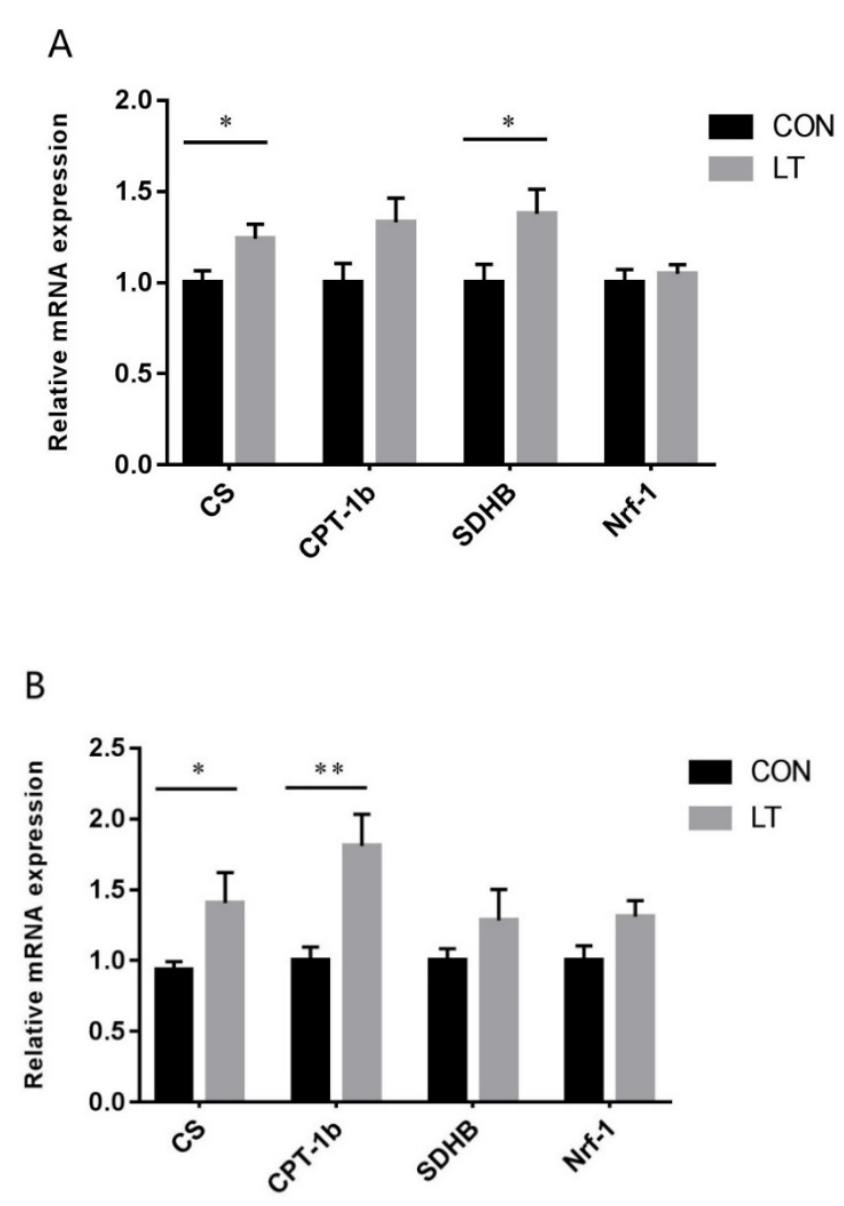
Figure 2. Effects of low-temperature on the mRNA expression level of mitochondrial function-related genes in ( A ) LM and ( B ) PM of weaned piglets. Results were the mean and standard errors. CS, citrate synthase; CPT-1b, carnitine palmitoyl transferase-1b; SDHB, succinate dehydrogenase-b; Nrf-1, nuclear respiratory factor 1. * Mean values were significantly different between two groups ( p < 0.05). ** Mean values were very significantly different between two groups ( p < 0.01).